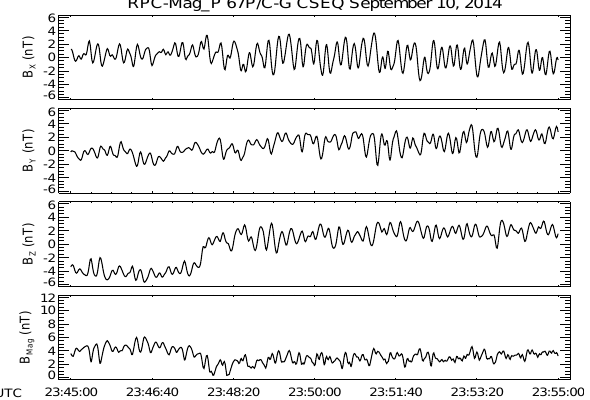
Figure 1. Example of magnetic field observations made onboard the Rosetta spacecraft on 10 September 2014, 23:45–23:55UTC. The position vector of the spacecraft in the comet-centered so- lar equatorial (CSEQ; for details see text) coordinate system was ( 3 . 9 , − 20 . 6 , 20 . 4 ) km.